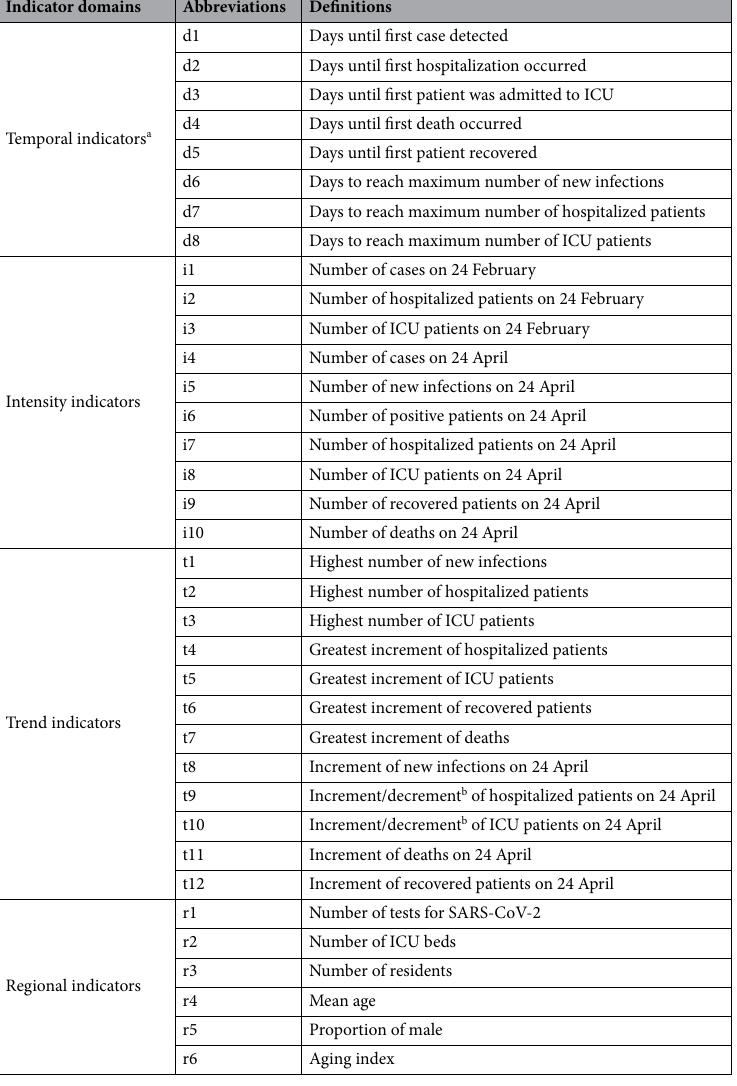
are computed as the number of days from 24 February, 2020. b These indicators represent daily increment